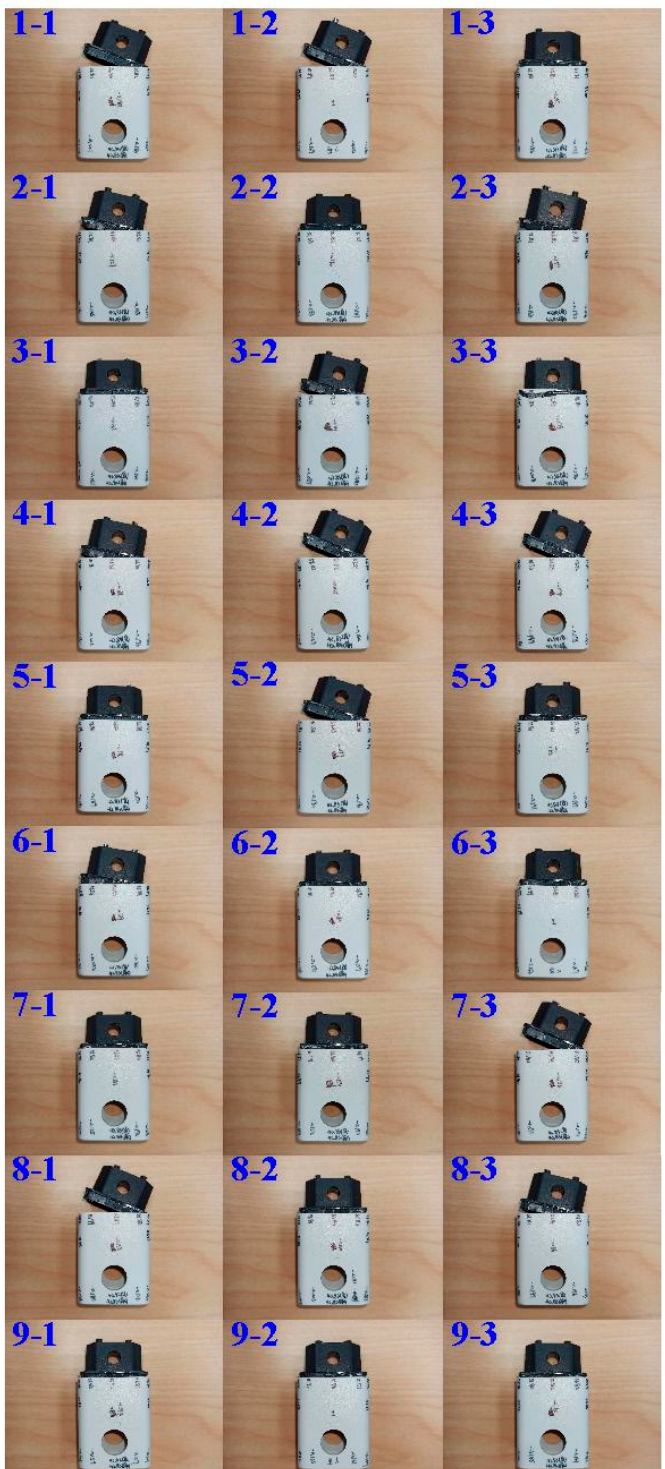
Figure 10. Results of tensile testing for parts fabricated by different process parameters.